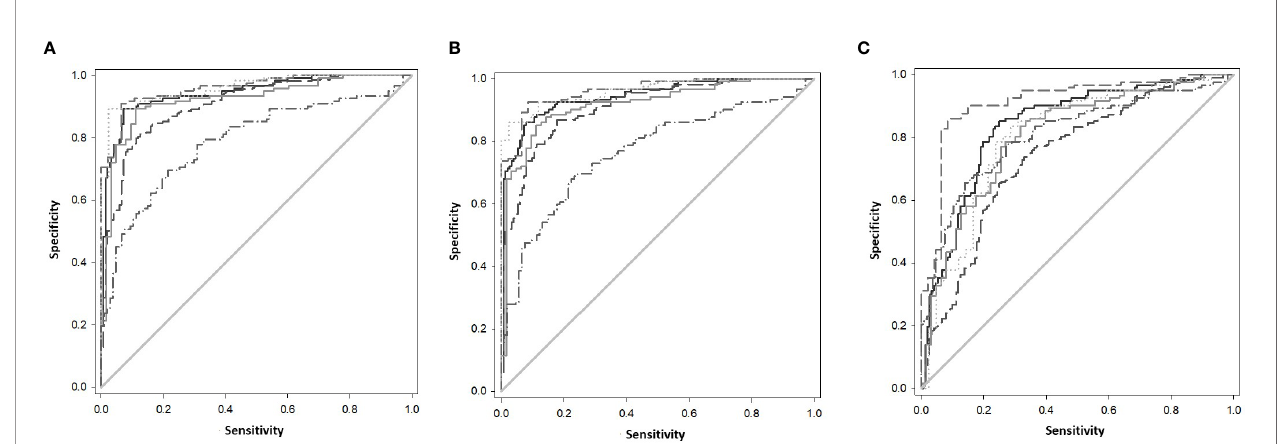
FIGURE 3 | (A) ROC Curve analysis of all individual TB disease groups compared to the CNTRLA group and combined CNTRL&LTBI vs ATB groups, using the GBP1+IFIT3 algorithm (B) ROC Curve analysis of all individual TB disease groups compared to the CNTRLA group and combined CNTRL&LTBI vs ATB groups, using the GBP1+IFIT3 +SAMD9L algorithm (C) ROC Curve analysis of all individual TB disease groups compared to the CNTRLA group and combined CNTRL&LTBI vs ATB groups, using the GBP1+IFITM3 algorithm All CNTRLS vs ATB